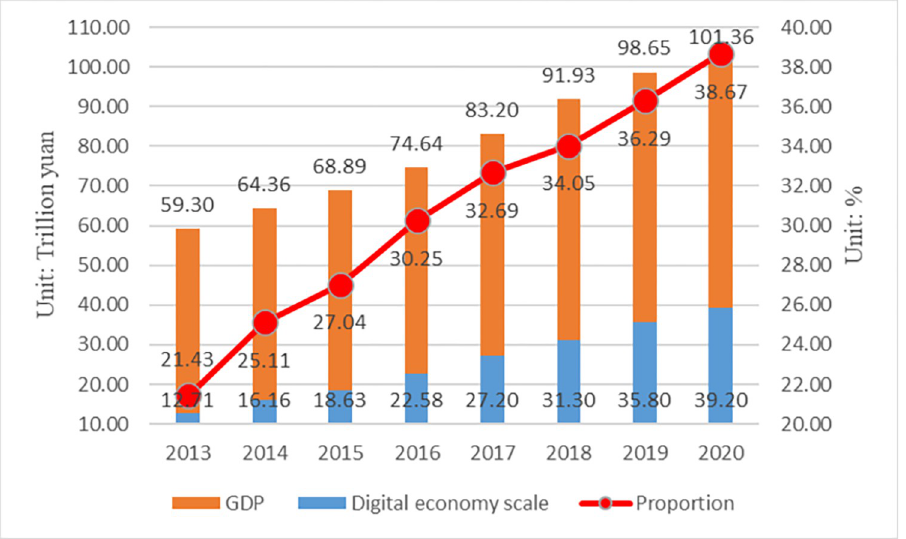
Fig 2. Proportion of the digital economy scale in GDP and its changes in